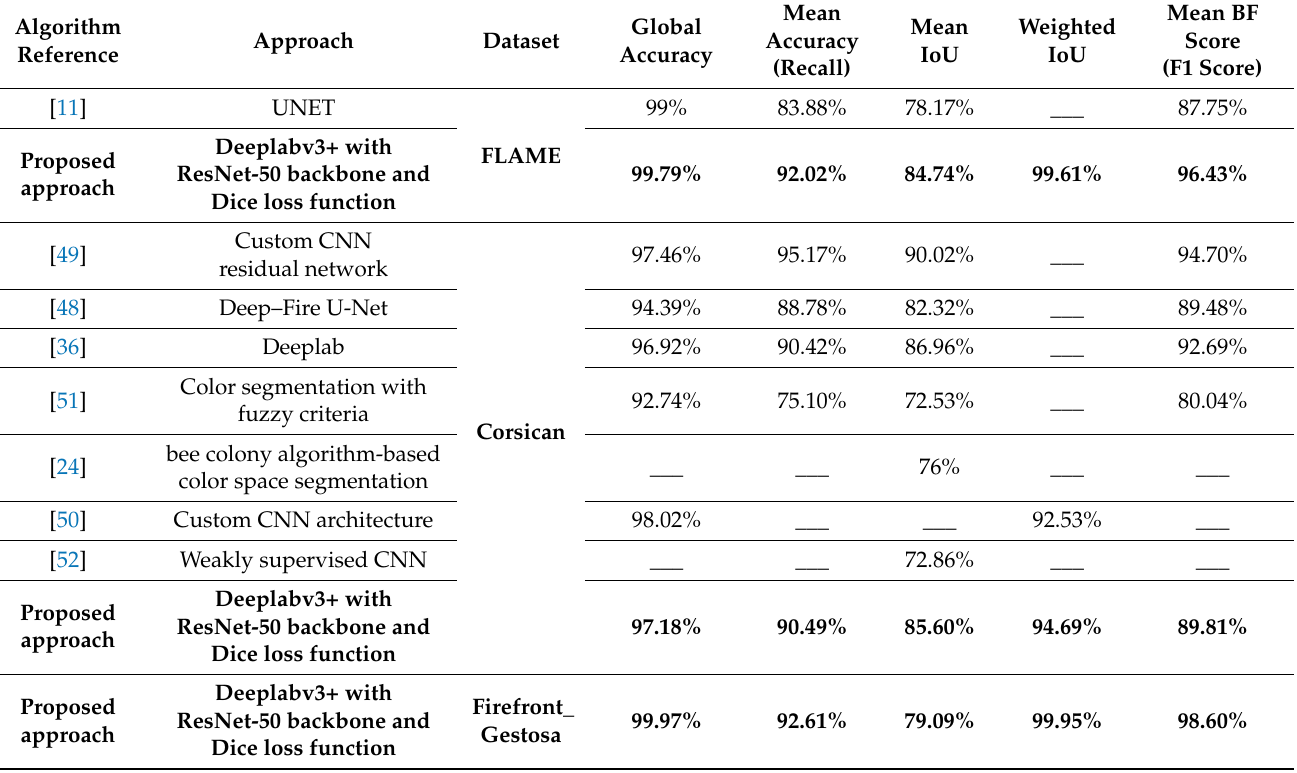
second rows are the pictures and their corresponding ground truths. The rows from three to seven represent the results given by the four models trained with dice loss. The pixels that should be detected as non-fire, but the model had labeled them as fire pixels (FP), are given in green color. Pink color design pixels that are fire ones, but the model had labeled them as non-fire pixels (FN). Table 8. Resume of the state-of-art, mainly the algorithms tested over FLAME and Corsican datasets: comparison with the current